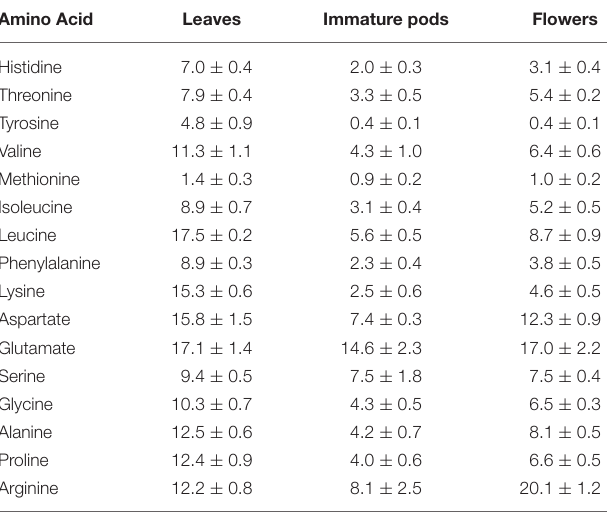
TABLE 2 | Amino acid pattern of Moringa oleifera leaves, immature pods and flowers in mg/g dry weight [adapted from Sánchez-Machado et al. ( 15)]. Amino